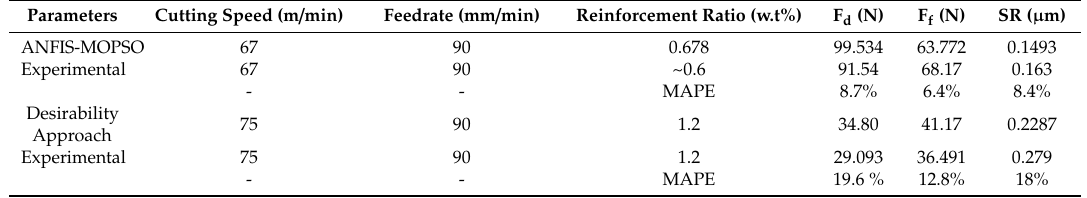
Table 13. Comparison of validation experiments for multi-objective